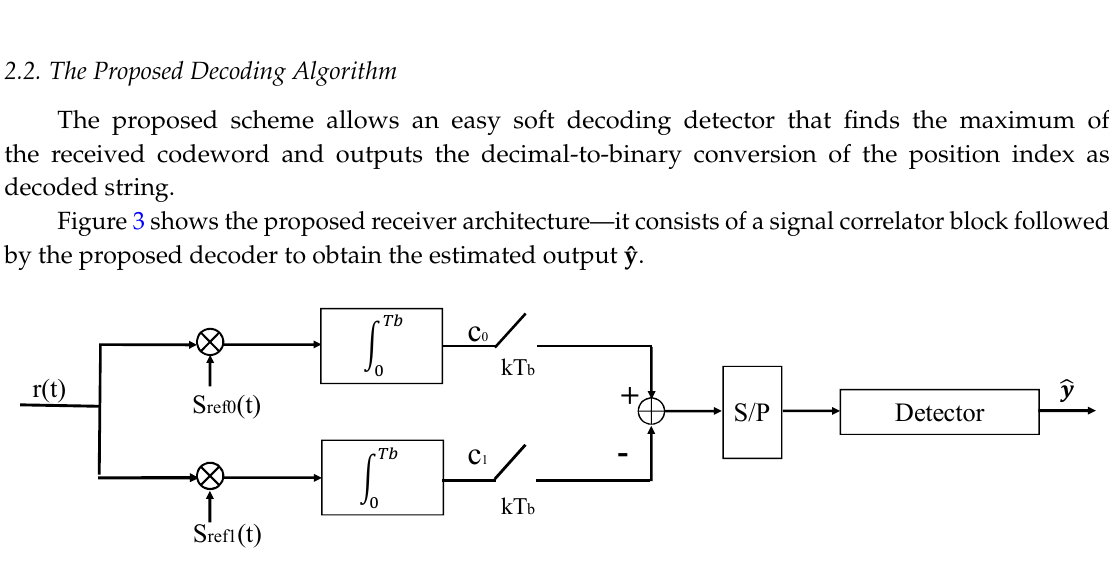
Figure 3. Proposed receiver architecture